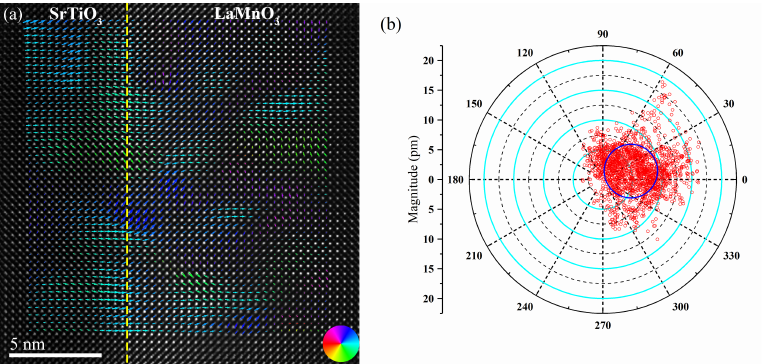
Figure 7. ( a ) ADF − STEM image with superimposed arrows representing the displacement of the Mn atoms with respect to the center of four neighboring A-site atoms. ( b ) The polar plot of the displacement of B-site